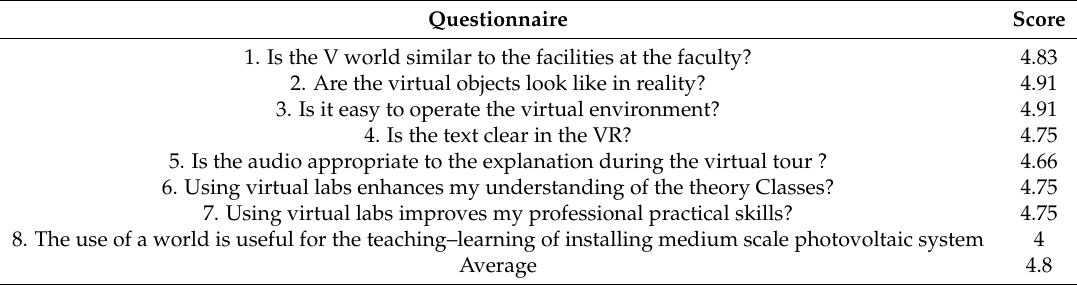
Table 4. User satisfaction